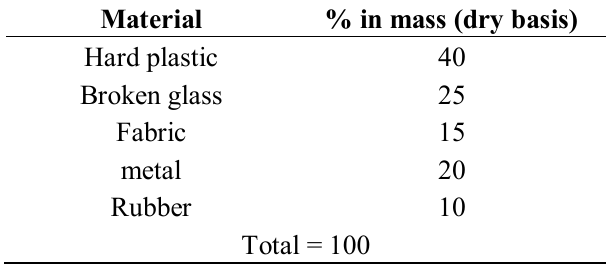
Table 2. Gravimetric composition of clinical solid wastes used in this